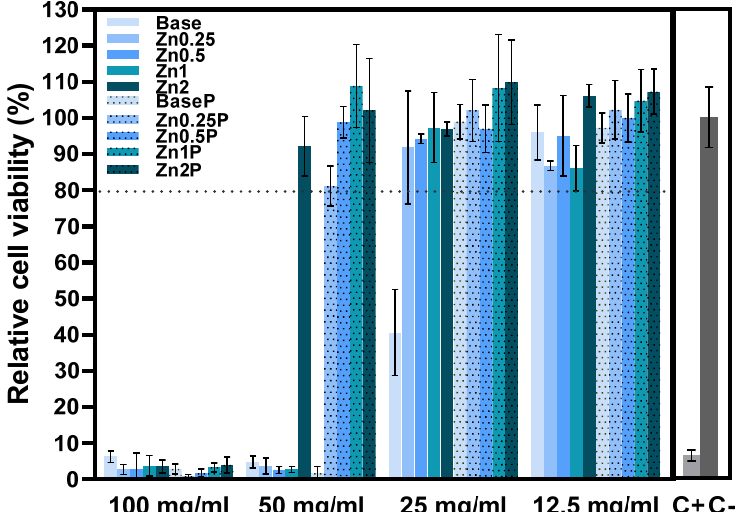
Figure 4. Relative cell viability of Saos-2 cells after 48 h incubation with non-passivated (Base, Zn0.25, Zn0.5, Zn1 and Zn2) and passivated (BaseP, Zn0.25P, Zn0.5P, Zn1P and Zn2P) bioactive glass extracts. Dot line is related to the percentage of cell viability above which extracts are not considered cytotoxic.